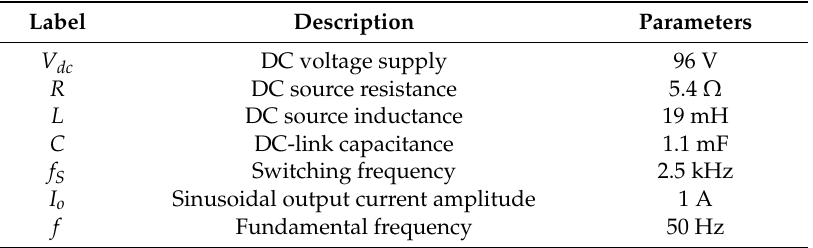
Table 1. Circuit